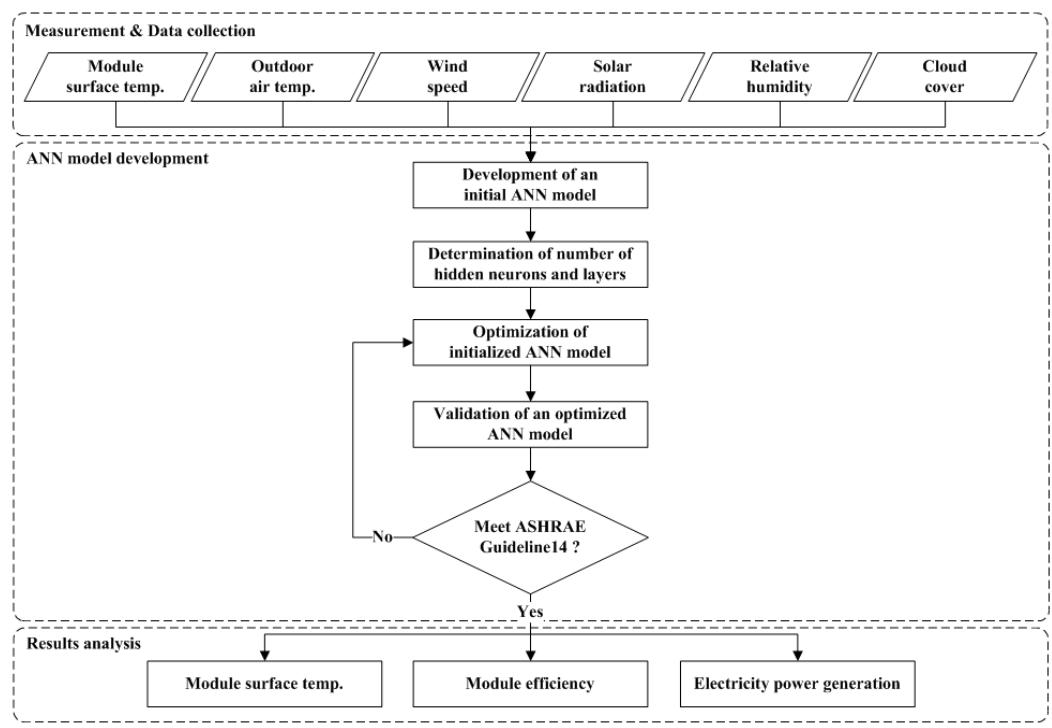
Figure 2. Overall study process.